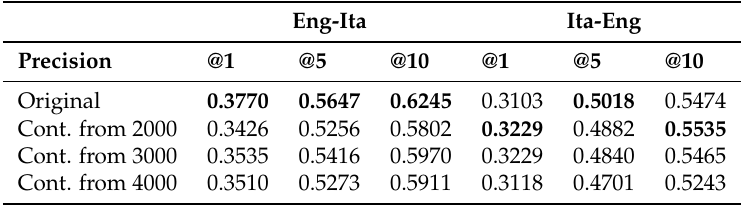
Table 11. Continuing the baseline system with the PanLex